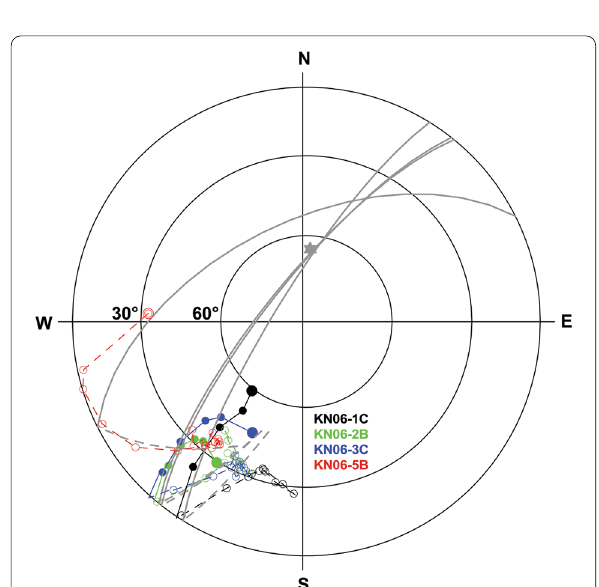
Fig. 5 Demagnetizations curves from the Steinberg site. Same representation as in Fig. 4